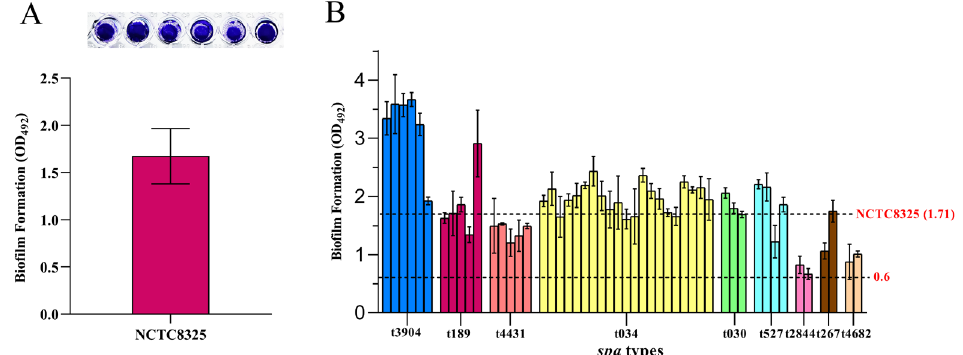
Figure 2. Biofilm formation ability of S. aureus NCTC8325 and 50 isolates. ( A ) As the positive control, detection of biofilm formation ability of S. aureus NCTC8325 by microtiter plate and a MicroELISA autoreader at a wavelength of 492 nm in single wavelength mode. ( B ) Detection of biofilm formation ability of 50 isolates by a MicroELISA autoreader at a wavelength of 492 nm in a single wavelength mode. Error bars indicate SD. The results represent the means of three independent experiments.